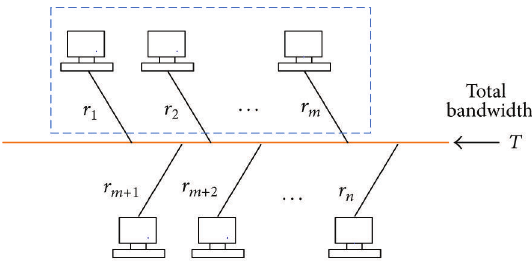
Figure 1: The system bandwidth allocation r = (𝑟 1 ,𝑟 2 ,...,𝑟 𝑛 ) subject to user-wise constraints: 𝑟 𝑖 ≤ 𝑟 𝑖 ≤ 𝑟 𝑖 for 𝑖 ∈ {1, 2,. . . , 𝑛} , and a user-grouping constraint 𝑅 𝑔 ≤ ∑ 𝑚 𝑖=1 𝑟 𝑖 ≤ 𝑅 𝑔 . The total allocation 𝑟 𝑇 , the total 𝑅 = ∑ 𝑛 𝑖 is less than 𝑖=1